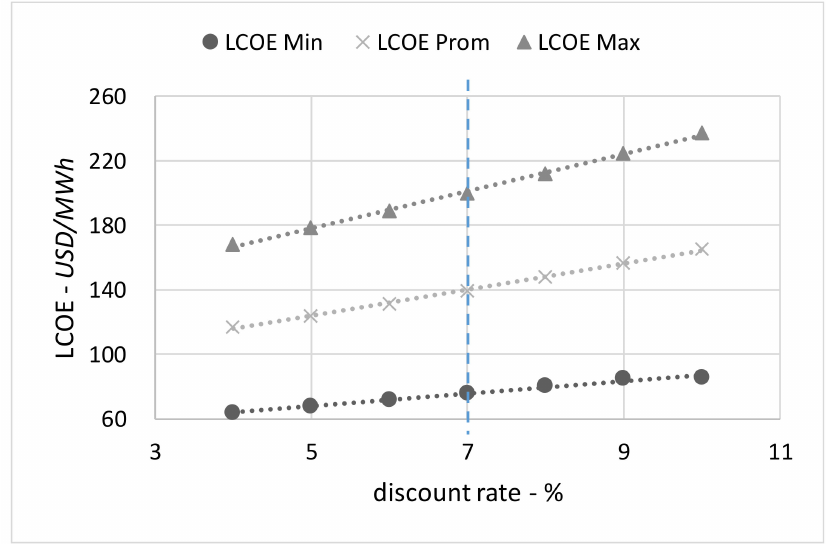
Figure 8. LCOE as a function of discount